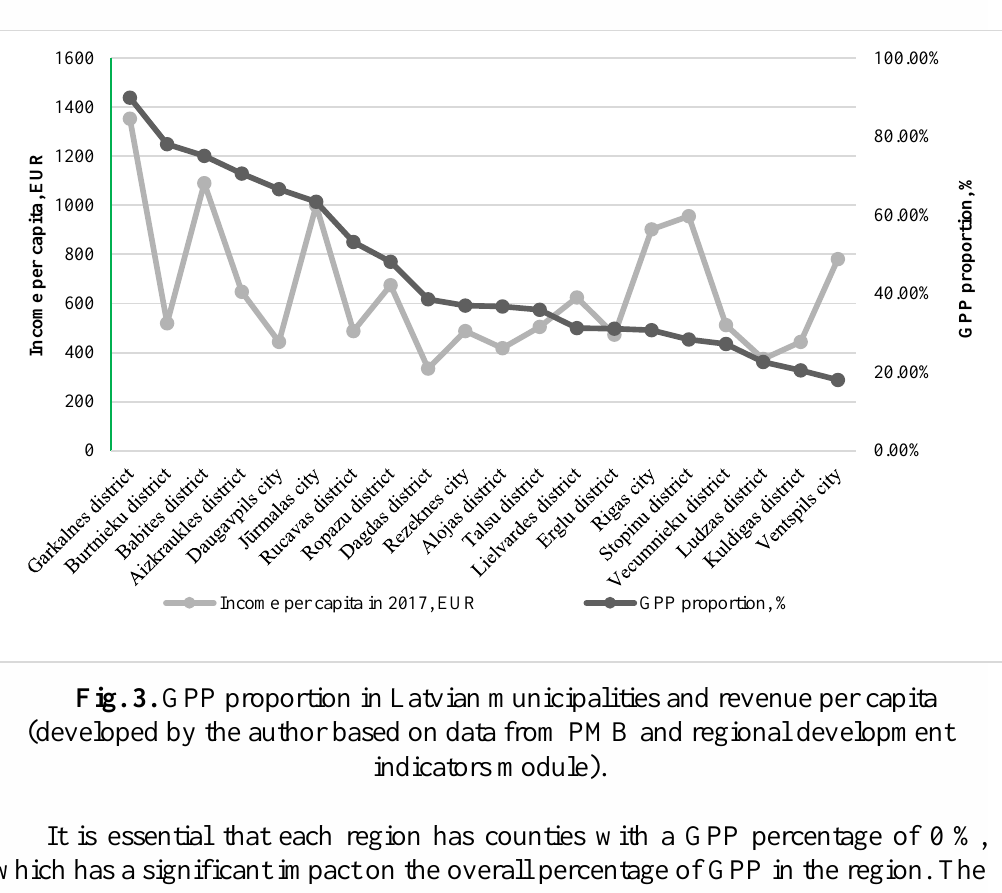
Fig. 3. GPP proportion in Latvian municipalities and revenue per capita (developed by the author based on data from PMB and regional development indicators